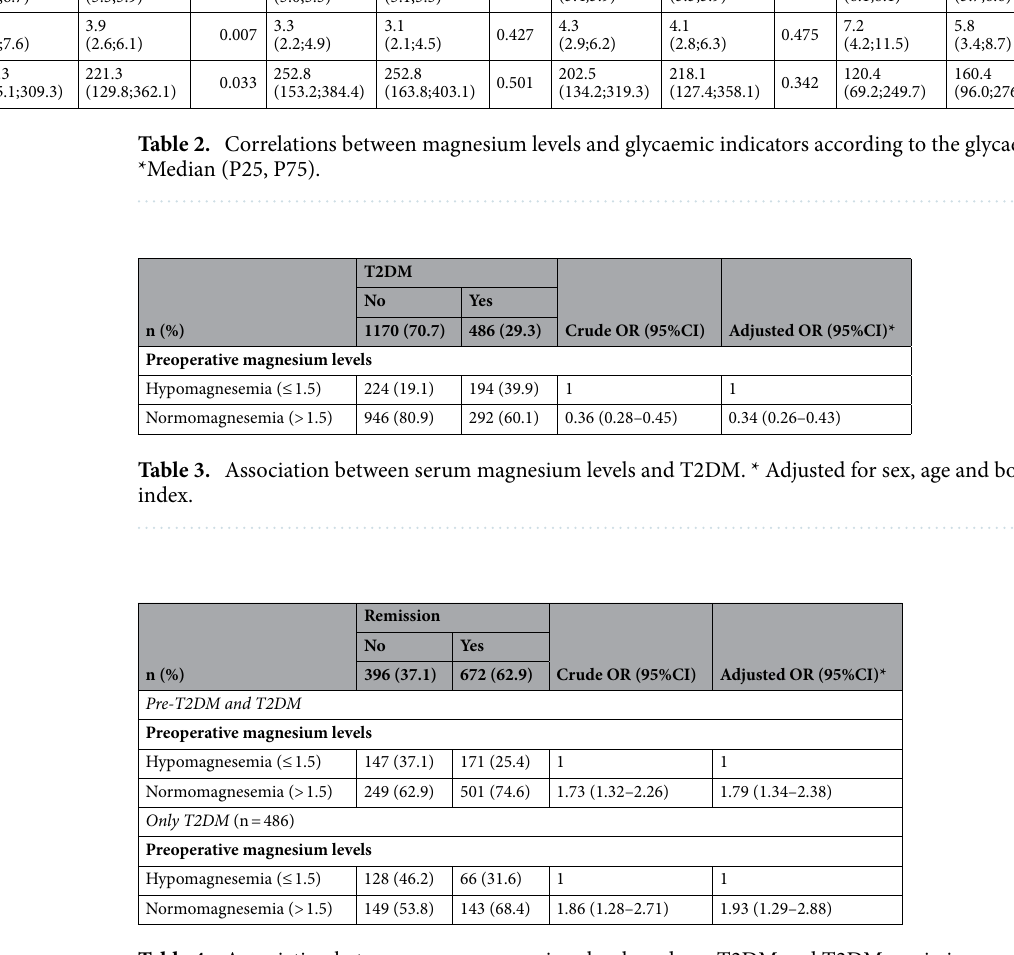
Table 4. Association between serum magnesium levels and pre-T2DM and T2DM remission, and only T2DM remission. CI, confidence interval; OR, odds ratio; T2DM, type 2 diabetes mellitus . *Adjusted for sex, age and body mass index.